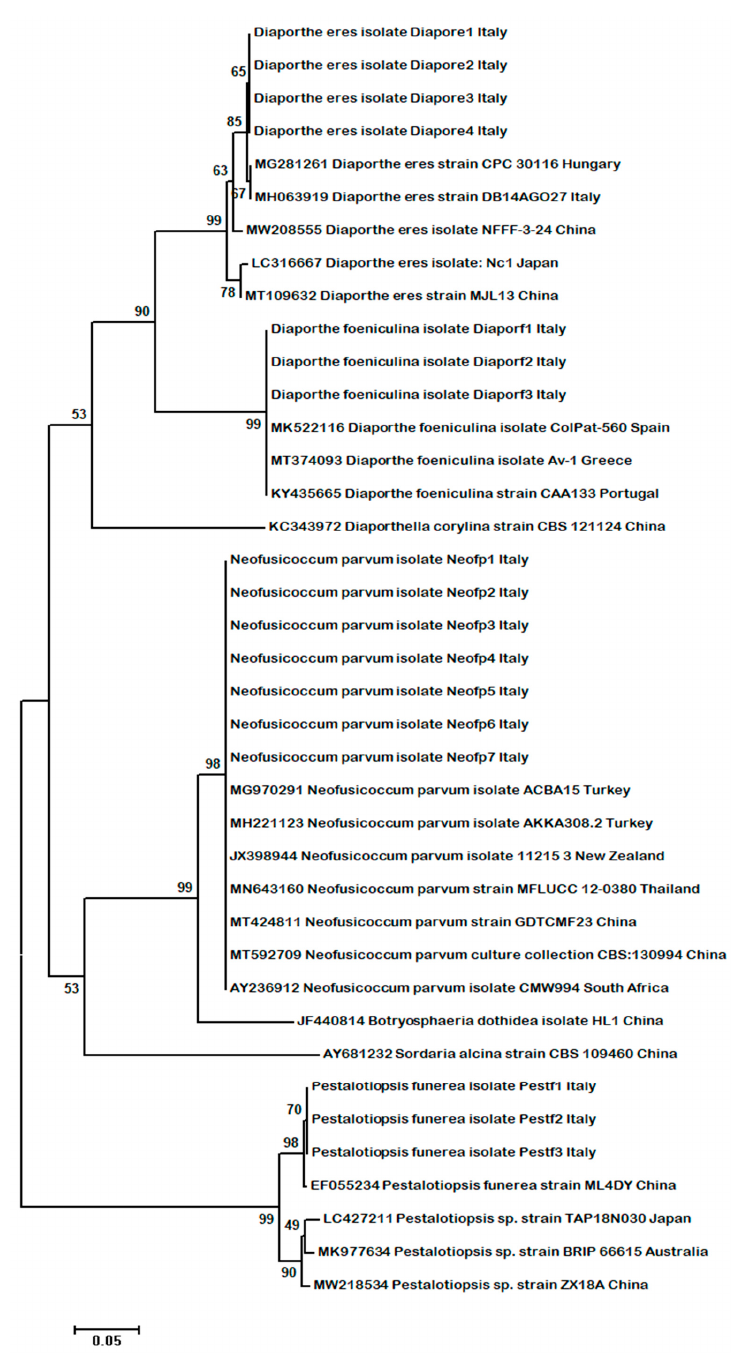
Figure 3. Molecular phylogenetic tree obtained through the neighbor-joining (NJ) method, based on the 39 tub-2 gene sequences data (500 bp) from fungal isolates in the present study and published sequences. The fungal species ( D. corylina , B. dothidea and S. alcina ) were used as outgroups in the analysis. The optimal tree with the sum of branch length = 1.08594872 is shown. The confidence probability estimated using the bootstrap test (1000 replicates) is shown next to the branches. The tree is drawn to scale, with branch lengths in the same units as those of the evolutionary distances used to infer the phylogenetic tree. The evolutionary distances were computed using the Tajima–Nei method and are in the units of the number of base substitutions/site. Scientific names of the fungi along with collection place, isolate abbreviation and GenBank AC number are shown in the